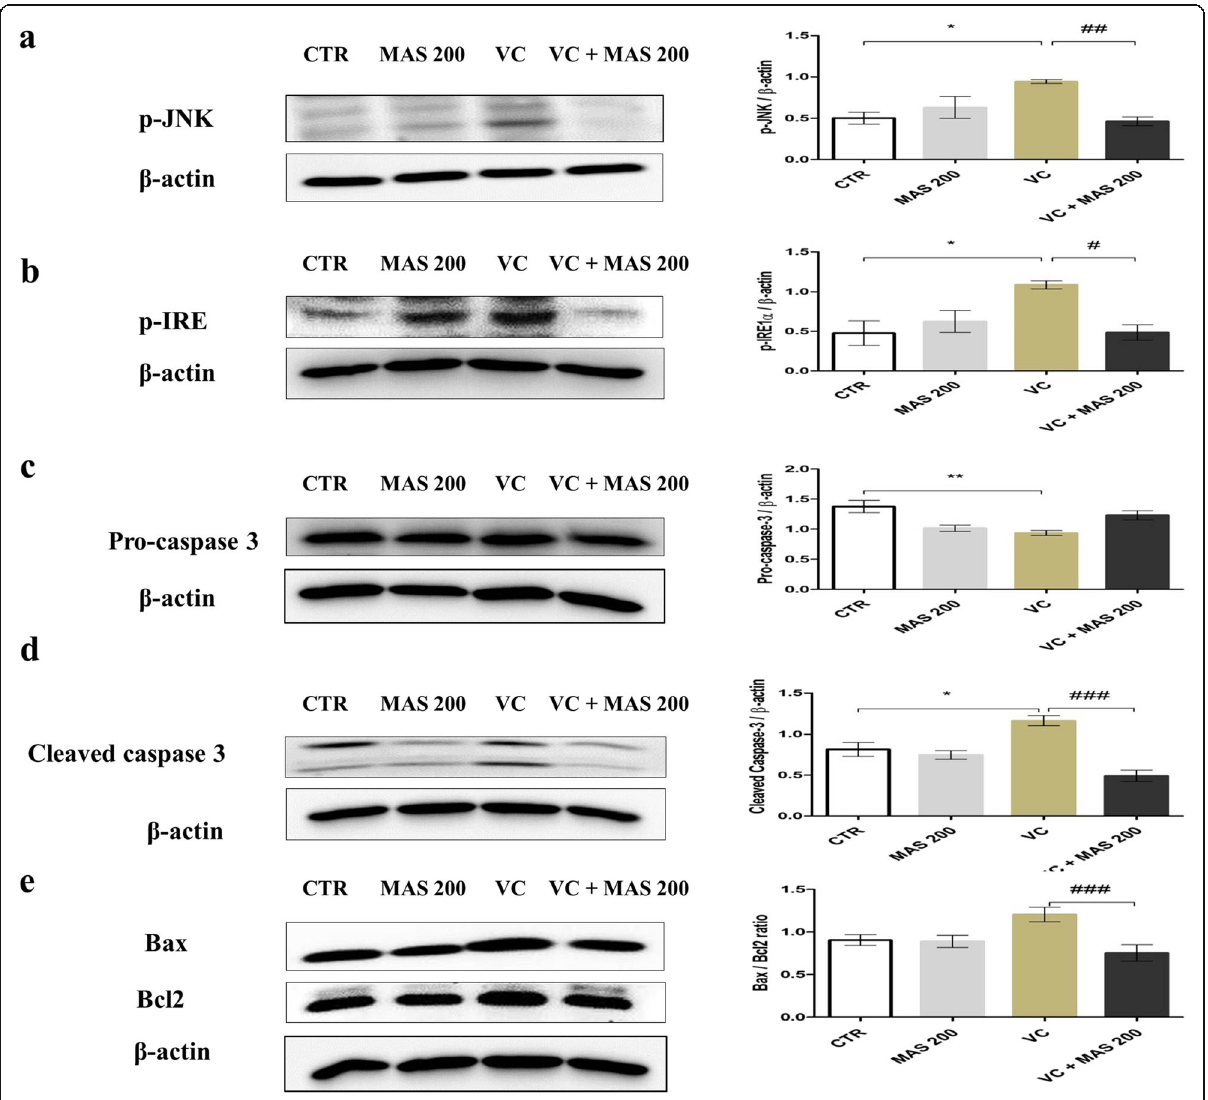
Fig. 3 Effect of MAS on testicular protein levels in varicocele (VC)-induced male SD rats determined by western blot analysis. a p-JNK, ( b ) p-IRE, ( c ) Pro-caspase-3, ( d ) cleaved caspase-3, ( e ) Bax:Bcl 2 ratio. Data are presented in mean ± SEM. The differences were tested by one-way ANOVA followed by Tukey ’ s post hoc test; n = 10 for each group. * Significant at P < 0.05; ** Significant at P < 0.01; *** Significant at P < 0.001- versus CTR group; # Significant at P < 0.05; ## Significant at P < 0.01; ### Significant at P < 0.001- versus VC group. CTR: control; MAS 200: MAS 200 mg/kg p.o.; VC: varicocele; VC + MAS 200: MAS 200 mg/kg p.o.; p.o.: per oral; ANOVA: analysis of variance; SEM: standard error of the